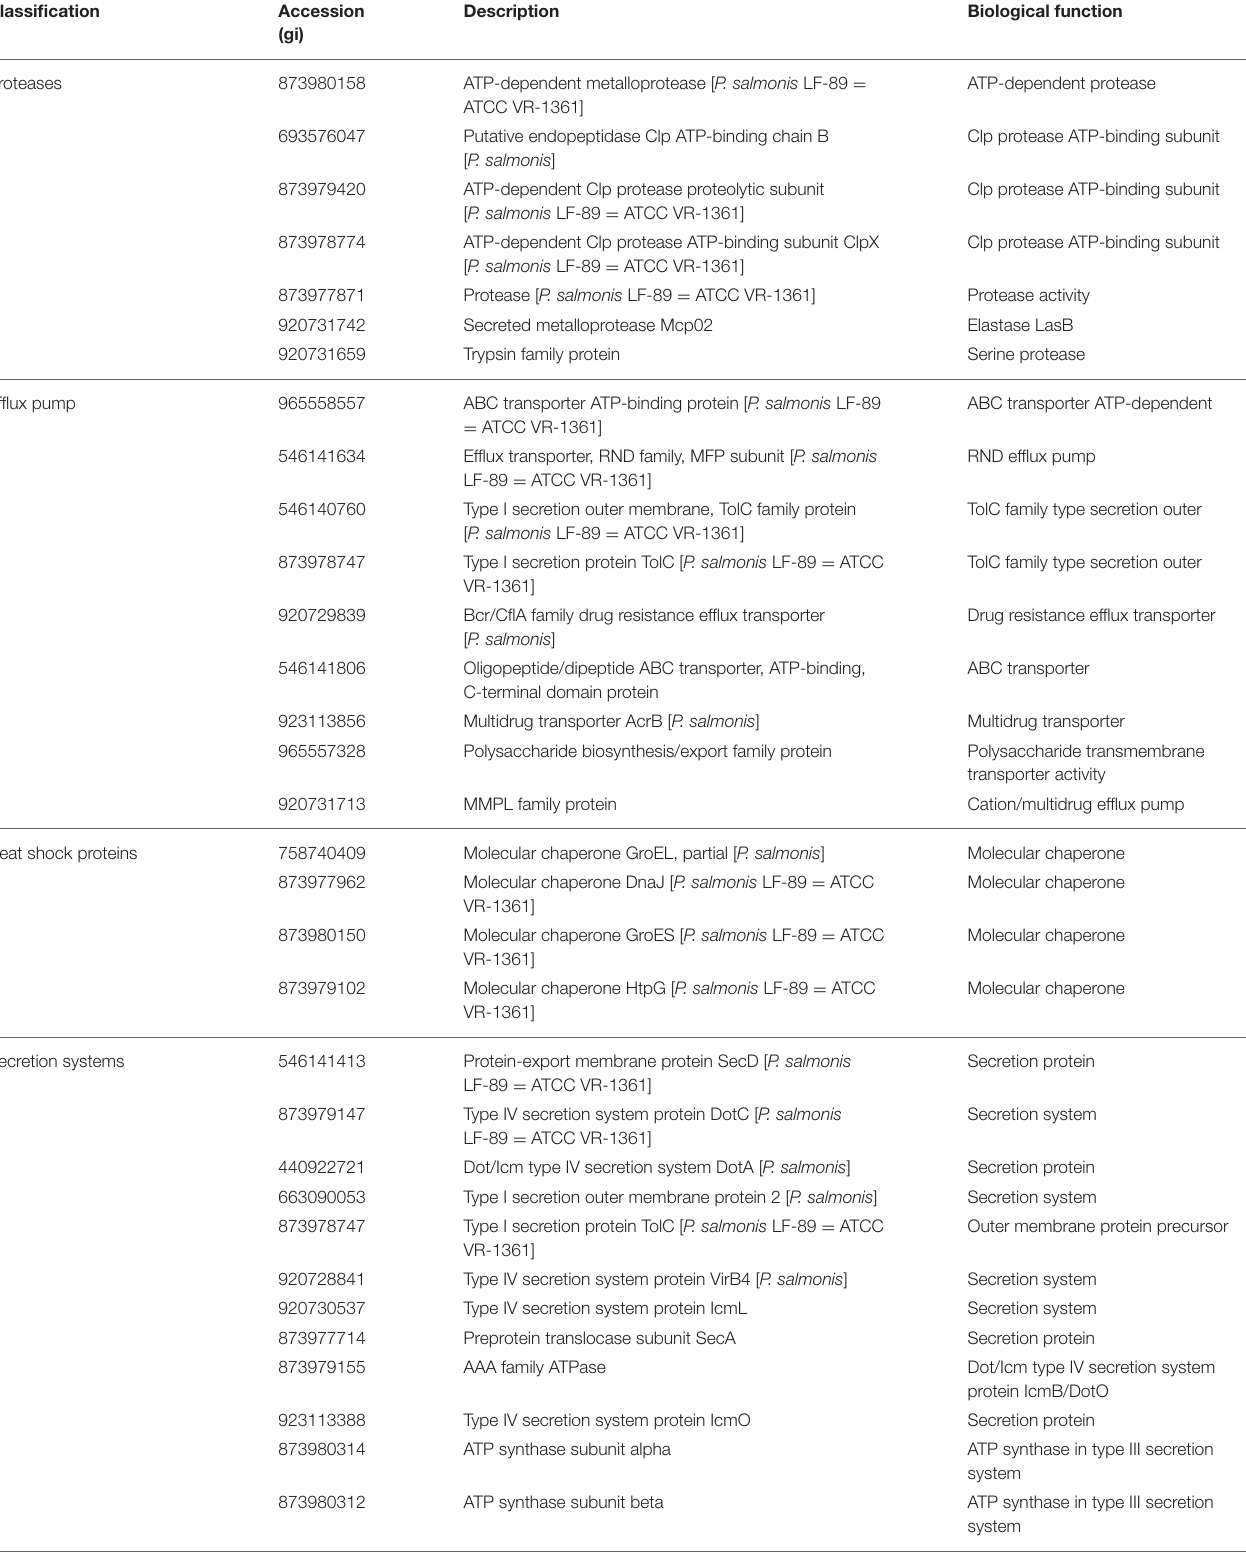
TABLE 3 | Classification of virulence-related proteins identified from Piscirickettsia salmonis LF-89 type strain membrane vesicles.